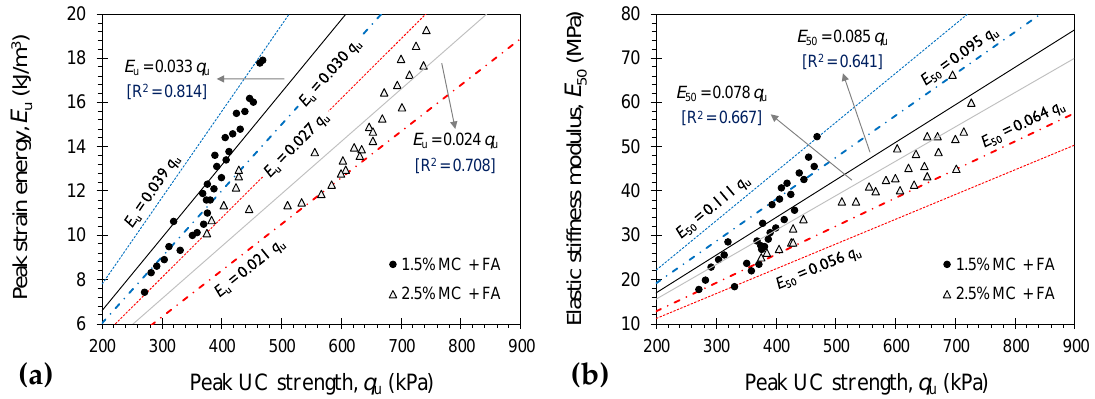
Figure 9. Variations of ( a ) peak strain energy E u and ( b ) elastic stiffness modulus E 50 against peak UC strength q u for various MC + FA-treated mixtures (i.e., M x F y T z where x = {1.5, 2.5}, y = {0, 0.5, 1.0, 1.5, 2.0, 2.5} and z = {7, 14, 28, 56, 128}).